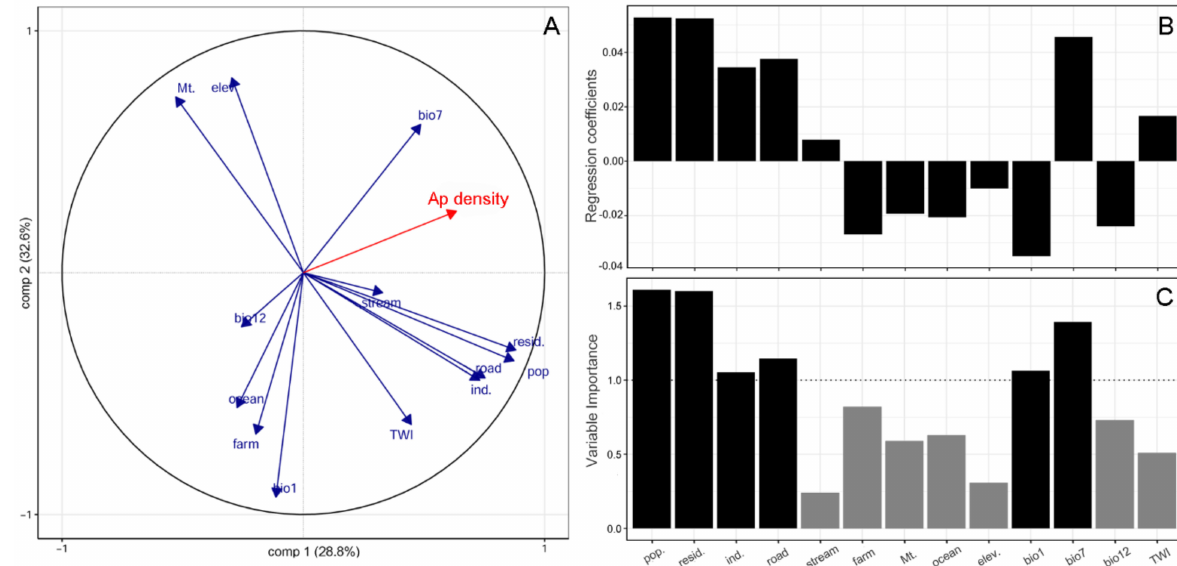
Figure 2. Partial least squares regression (PLSR) biplot of the first two components ( A ). Regression coefficient ( B ) and variable importance to the projection (VIP) ( C ) from the PLSR of A. pilosus (Ap) density. The variables with VIP > 1 are good candidates to explain A. pilosus density; pop.: human population density, resid.: residential area, ind.: industrial area, road: road length ratio, stream: stream area, farm: farm area, Mt.: mountain area, ocean: facing the ocean, elev.: elevation, bio1: annual mean temperature, bio7: annual temperature range, bio12: annual precipitation, and TWI: topographic wetness